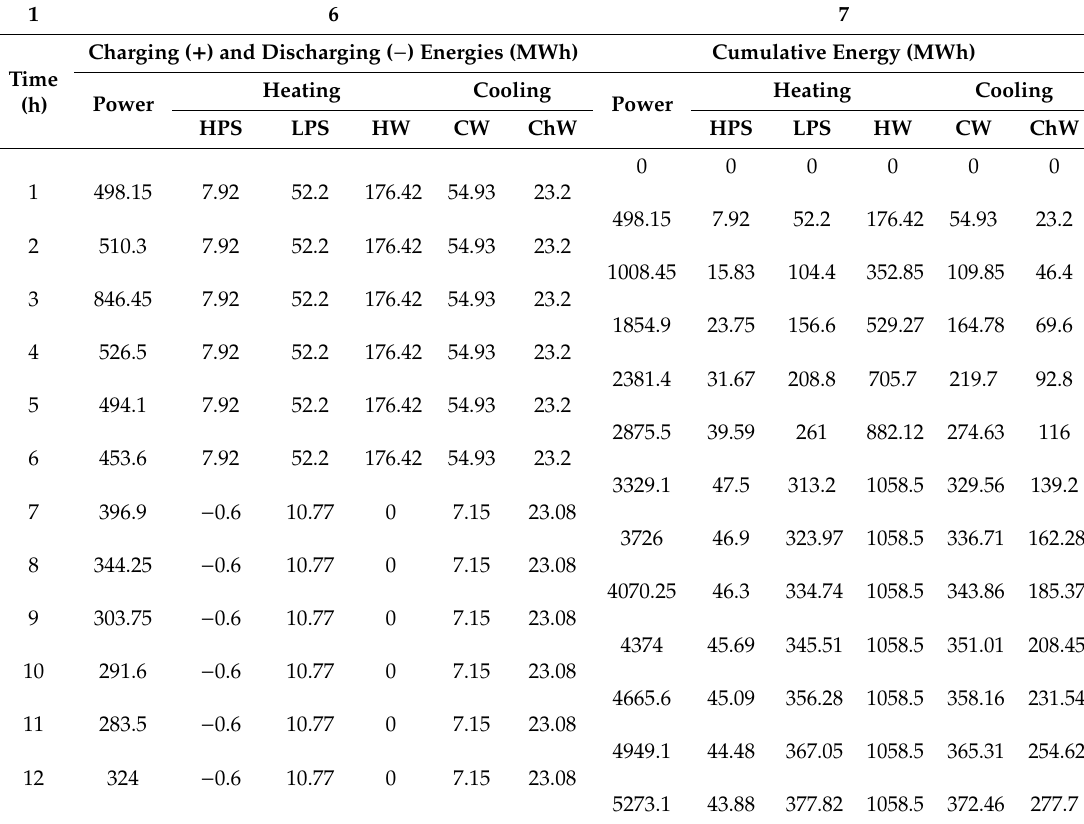
Table A5. TriGenSCA before iteration from time 1 to 12